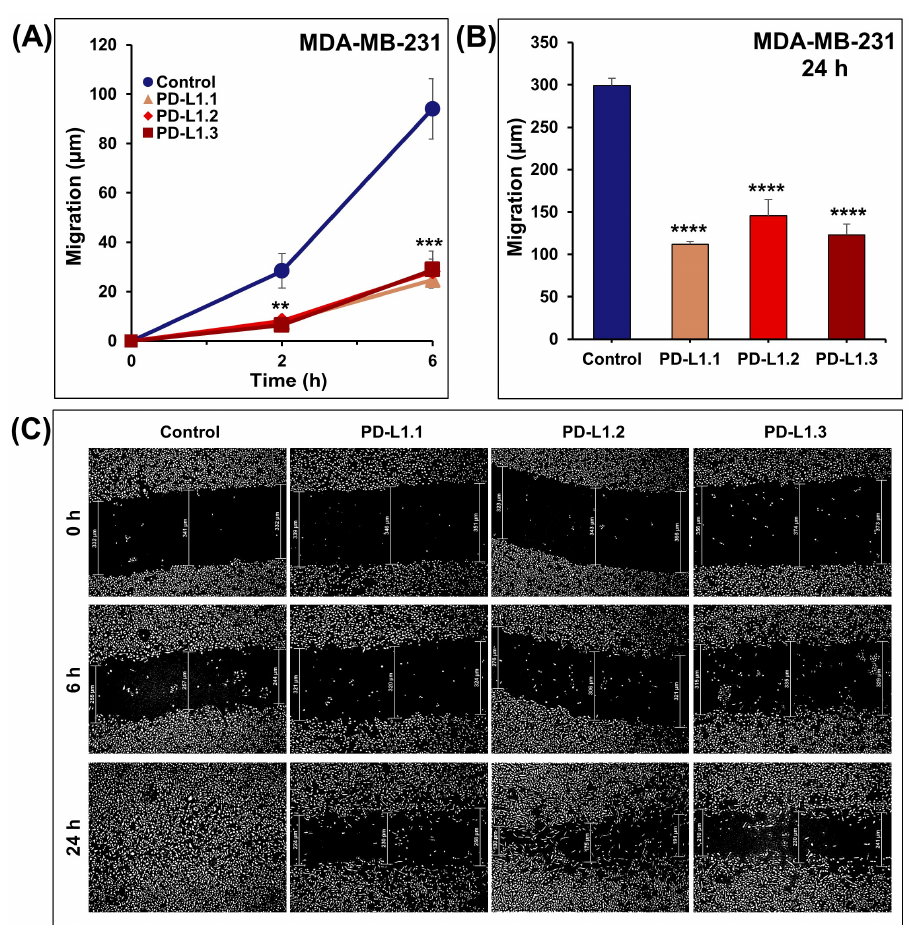
Figure 4. PD-L1 knockout significantly decreases MDA-MB-231 cell migration in vitro. Using wound healing assay, scratches were introduced to the adherent monolayer of control and PD-L1 knockout cells. ( A , B ) Migration distance was determined after 2, 6, and 24 h. ( C ) Representative pictures of the healing progress of the induced wounds at the indicated time points. Experiments were repeated at least three times. Columns or shapes are means; bars are S.E.M. ** p < 0.01. *** p < 0.001. **** p < 0.0001.